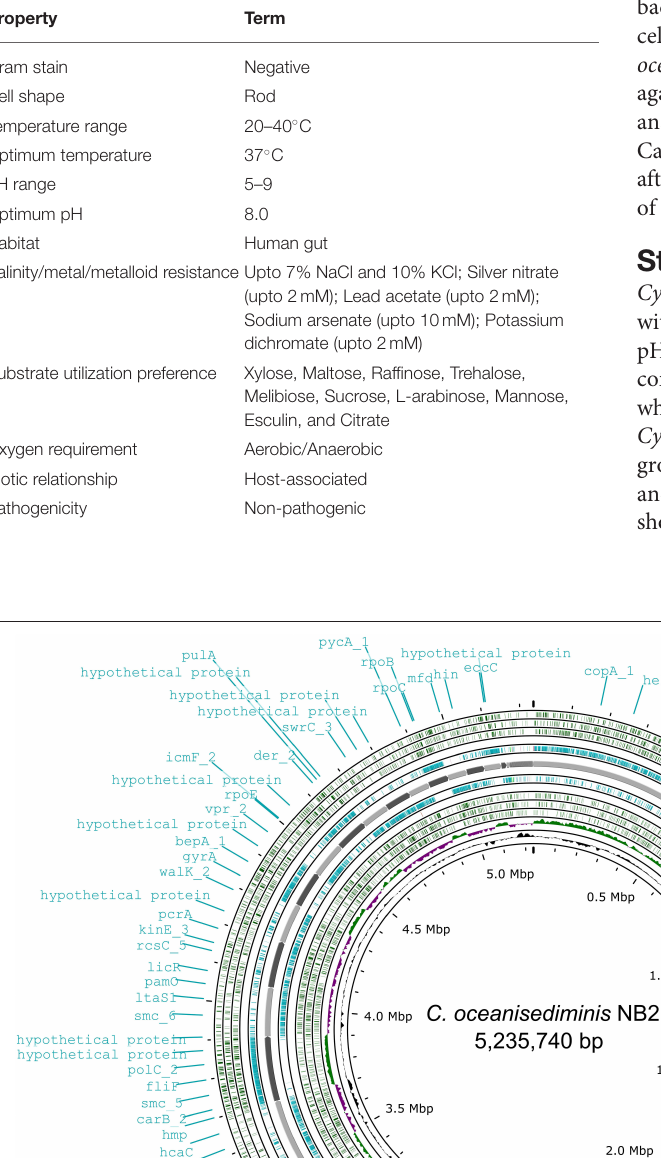
TABLE 1 | Physiological, morphological, and biochemical characterization of Cytobacillus oceanisediminis NB2. Property